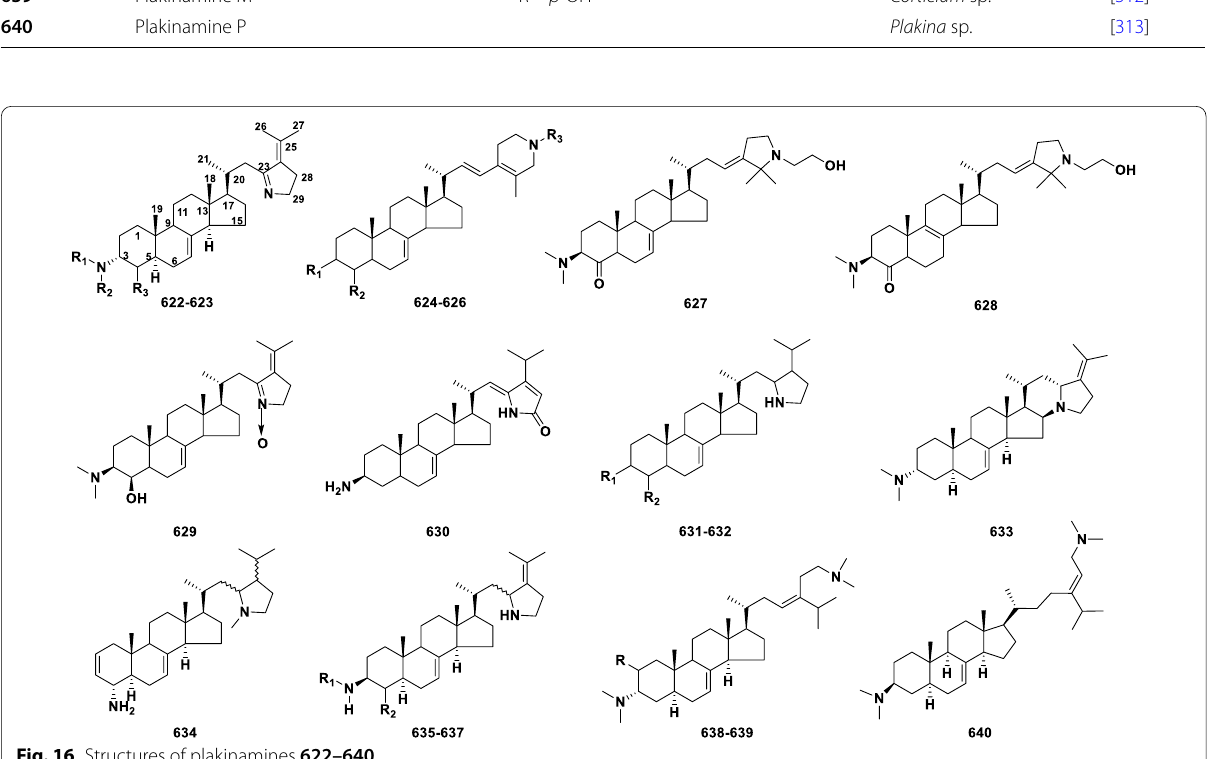
Fig. 16 Structures of plakinamines